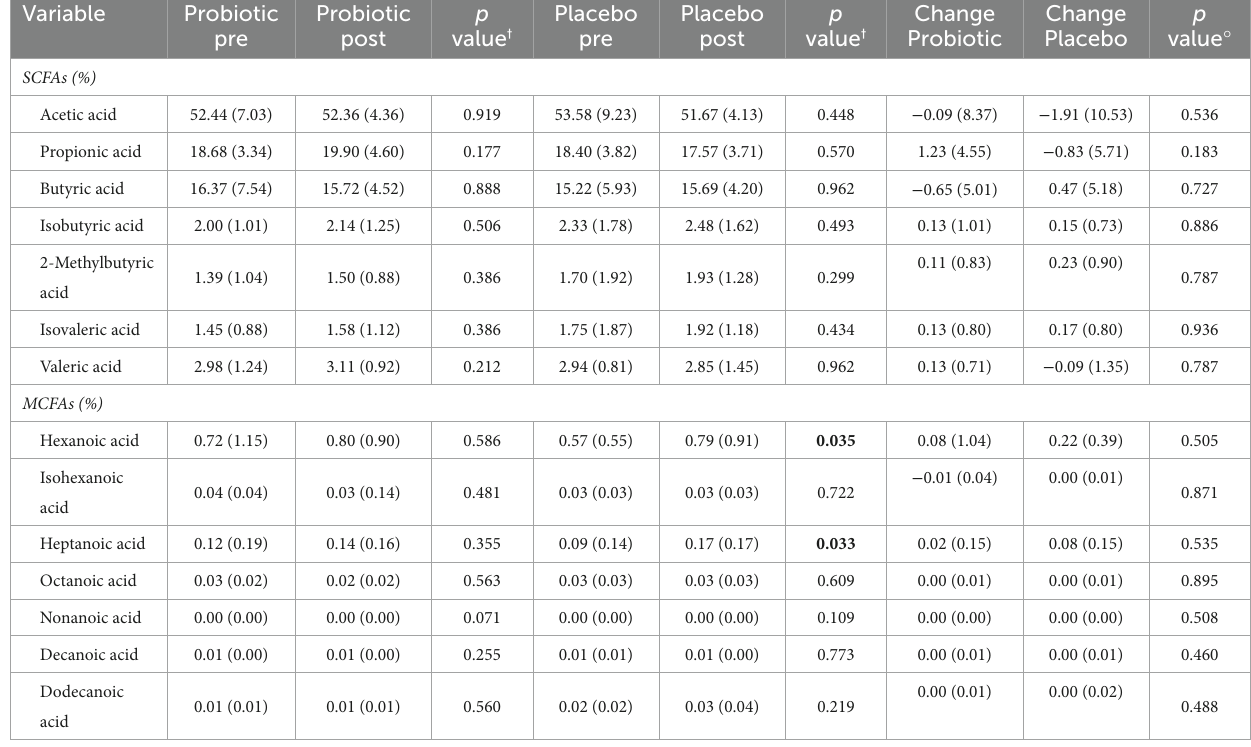
TABLE 5 SCFAs and MCFAs variation according to the dietary